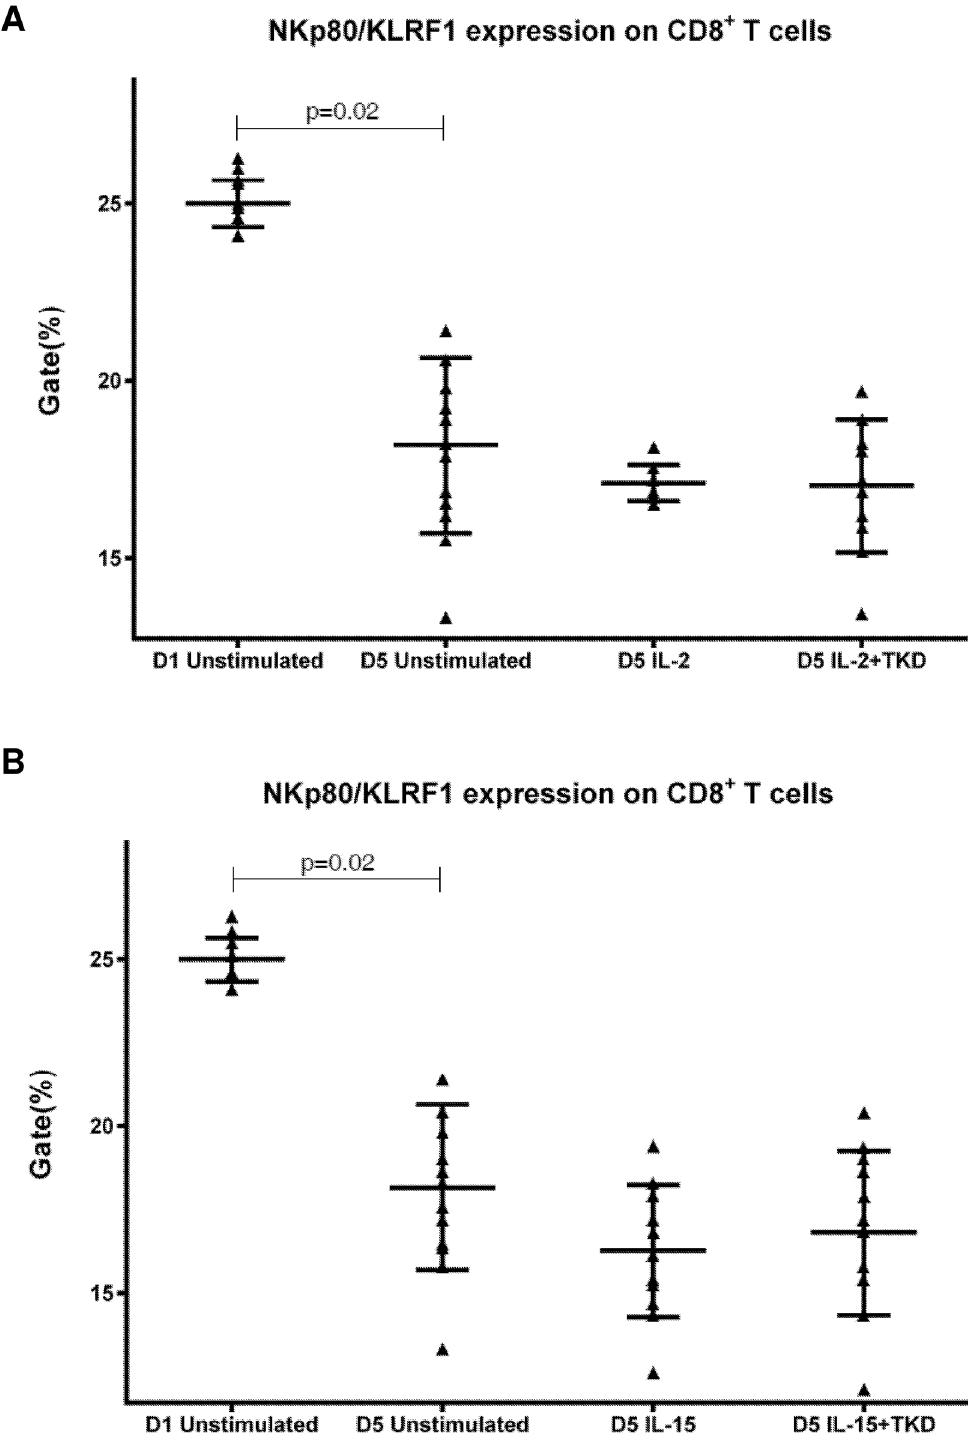
Fig 10. The effect of IL-2, IL-15, IL-2/TKD and IL-15/TKD on the expression of NKp80 receptor in peripheral blood mononuclear cells of healthy individuals — the proportion of CD8 + T cells expressing an appropriate receptor. The expression of NKp80 receptor on CD8 + T cells was examined within the fraction of unstimulated and stimulated mononuclear cells derived from 10 healthy individuals. Data are presented as means ± standard error. In total, the study cohort consisted of 52 Caucasian healthy individuals.